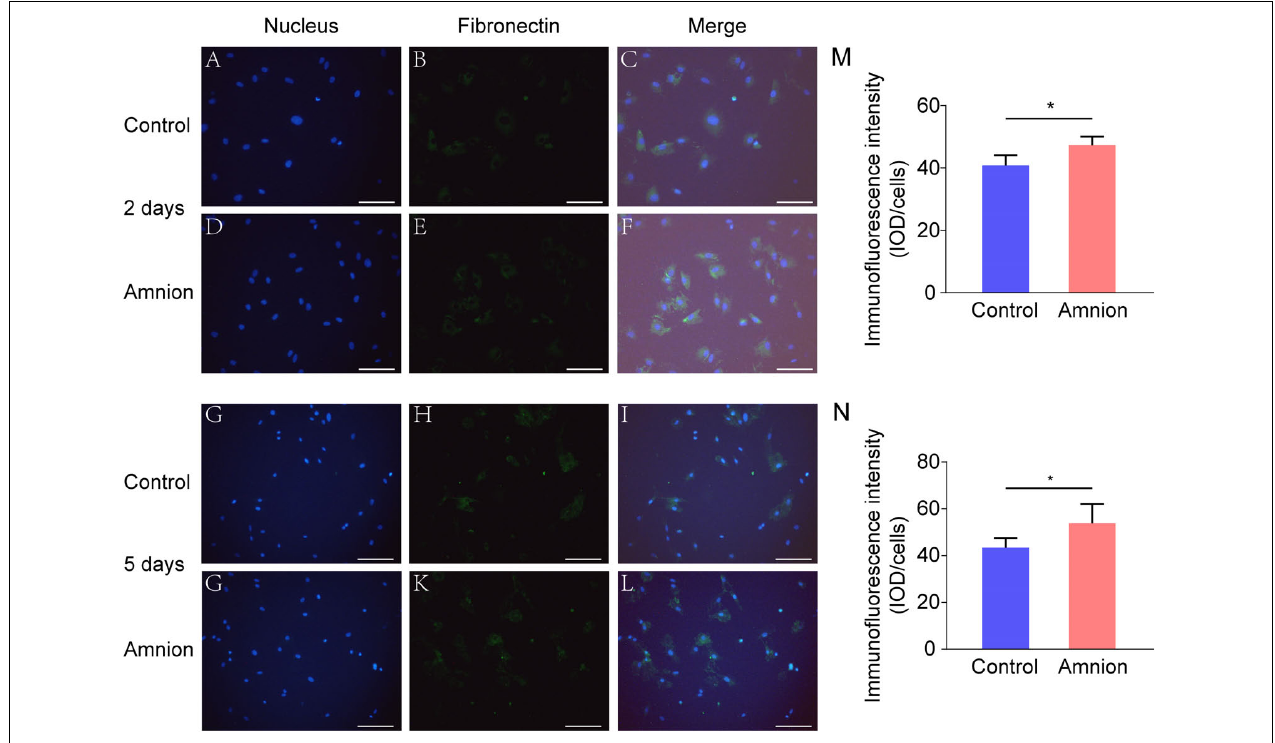
FIGURE 4 | Representative immunofluorescence images of fibronectin. Fluorescent micrographs of tenocytes after 2 and 5 days of culture on the surface of a culture plate and acellular amniotic membrane. Tenocyte nucleus shape observed under a fluorescence microscope (A,D,G,J) . Fibronectin presented positive after the fluorescent FITC mark was observed under a fluorescence microscope (B,E,H,K) . Tenocyte nucleus and fibronectin merging (C,F,I,L) . The corresponding semi quantitative analysis of fibronectin fluorescence intensity in panels (M,N) (scale bar = 50 um, n = 5, * P <